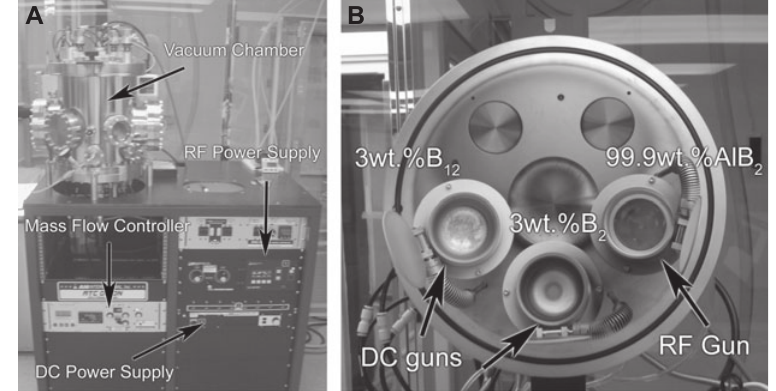
Figure 1 Sputtering system.